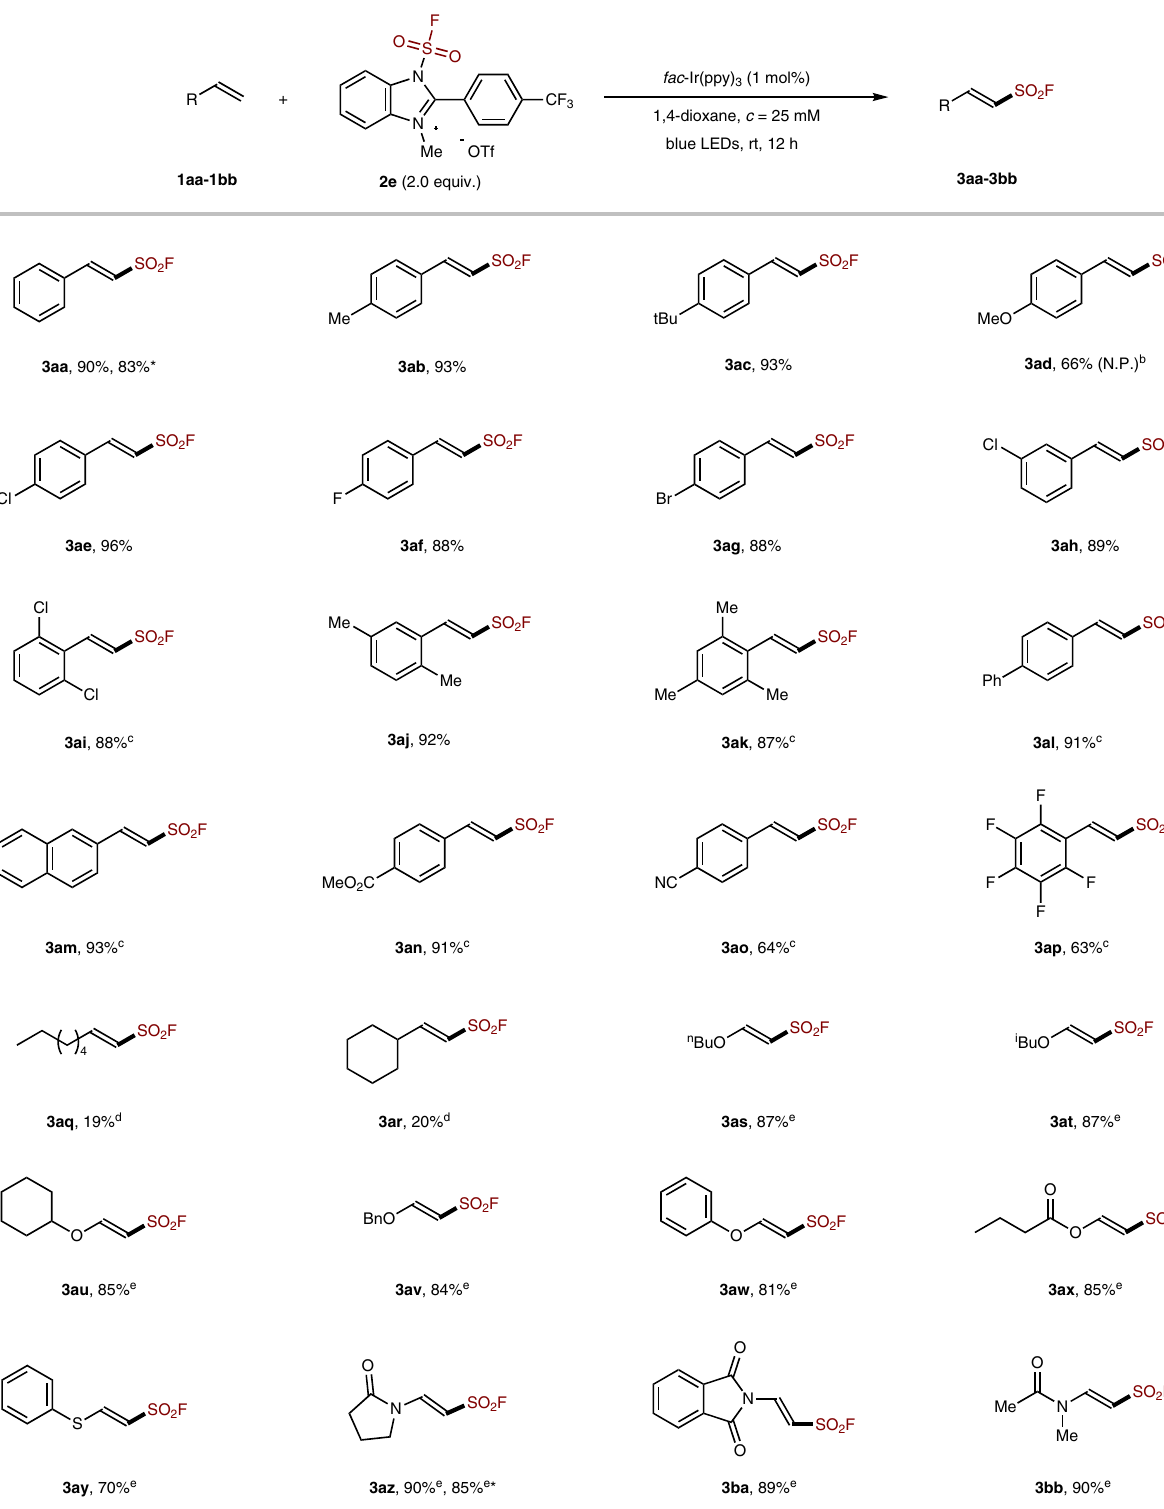
Fig. 3 The scope of radical fl uorosulfonylation of terminal ole fi ns and electron-rich alkenes. The reactions were performed on 0.1 or 0.2 mmol scales, with 2 equiv. of 2e in 1,4-dioxane at room temperature for 12 h. a Yields on 1.0 mmol scale. b The yields in parentheses are the reactions with FSO 2 Cl 50 . c With 3.0 eq. of 2e . d With 1.0 eq. of K e With 1.0 eq. of K 3 PO 4 . 2 CO 3 . *Yields on 1.0 mmol